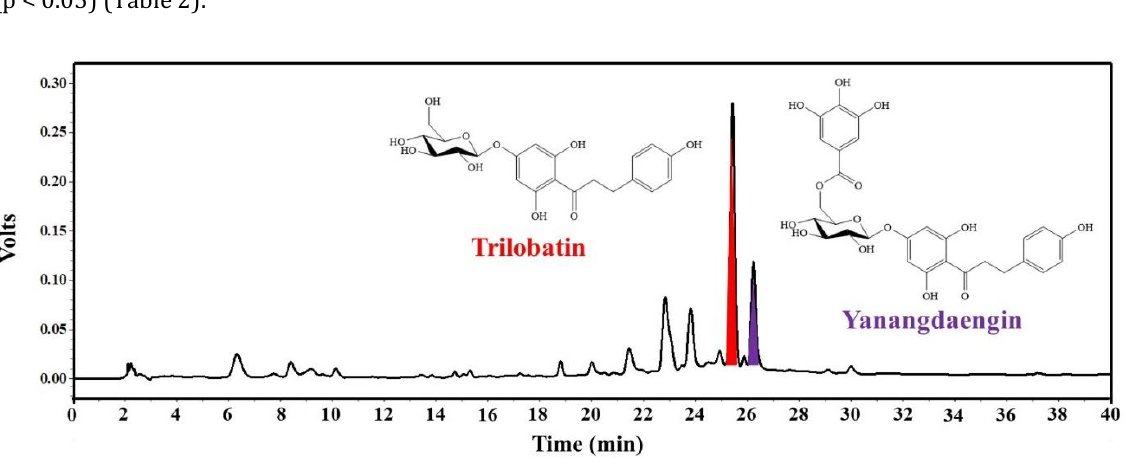
Fig. 3: The HPLC chromatogram of LS